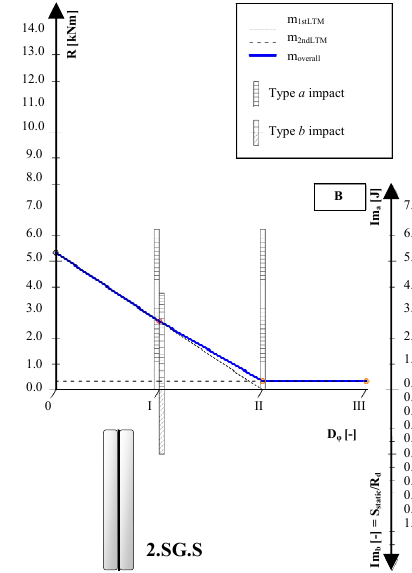
Figure 7: Element Safety Diagram for triple layer, PVB-laminated, heat strengthened glass beam.